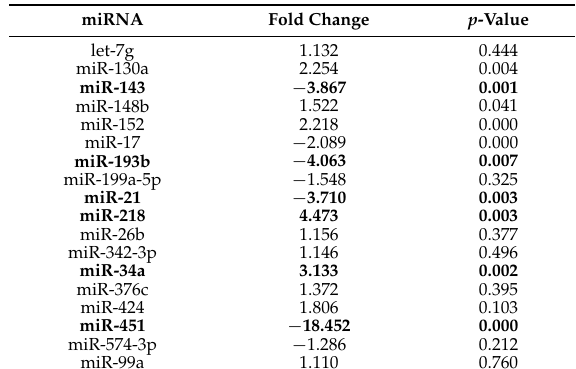
Table 3. Overview of the RT-qPCR validation of miRNA expression with fold change and p-value, average tumor vs. average normal dura. Summary of significant ( p -value <0.05) miRNAs with fold change above three are marked in bold. Human miR-191, miR-16 and let-7a are reference miRNA genes [42]. 15 tumor samples were used (12 different grade I tumors, and three grade II tumors) in comparison to five normal dura controls (see Table